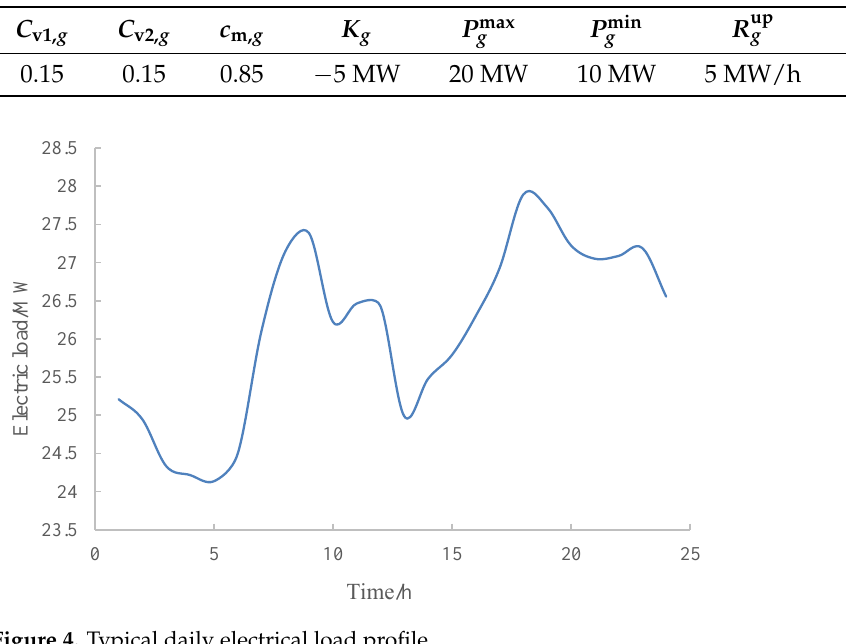
Figure 4. Typical daily electrical load profile.